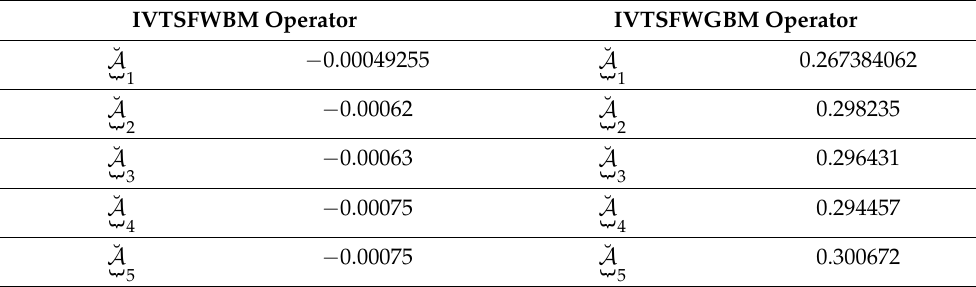
Table 6. Score values of the aggregated values in Table 5.